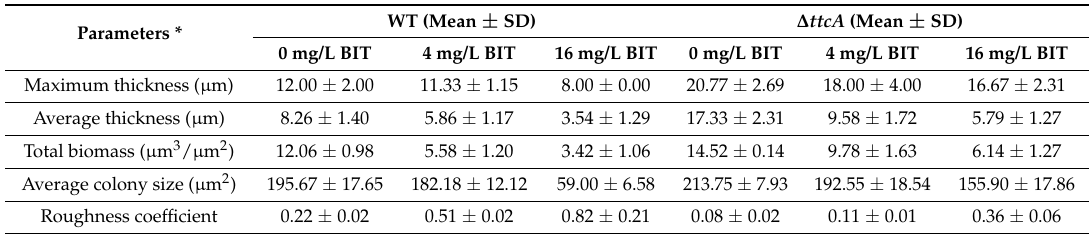
Figure 5. Swimming motility of C. werkmanii BF-6 ( A , B ) and Δ ttcA ( C , D ) on semisolid agar plates supplemented with 0 or 4 mg/L BIT. Aliquots of 5 μ L suspensions were inoculated at the center of the plate with a micropipette and then cultured for 24 h at 30 °C. Table 3. Quantitation of biofilm